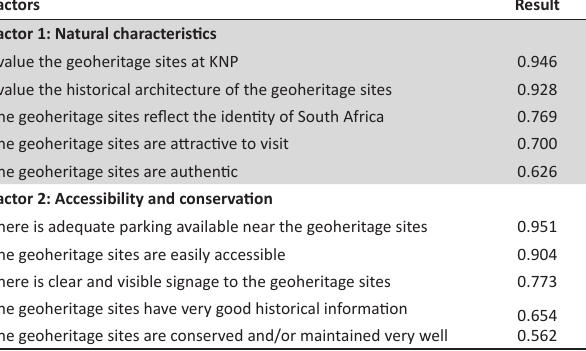
TABLE 3: Factor analysis for visitors’ attributes towards geoheritage sites. Factors